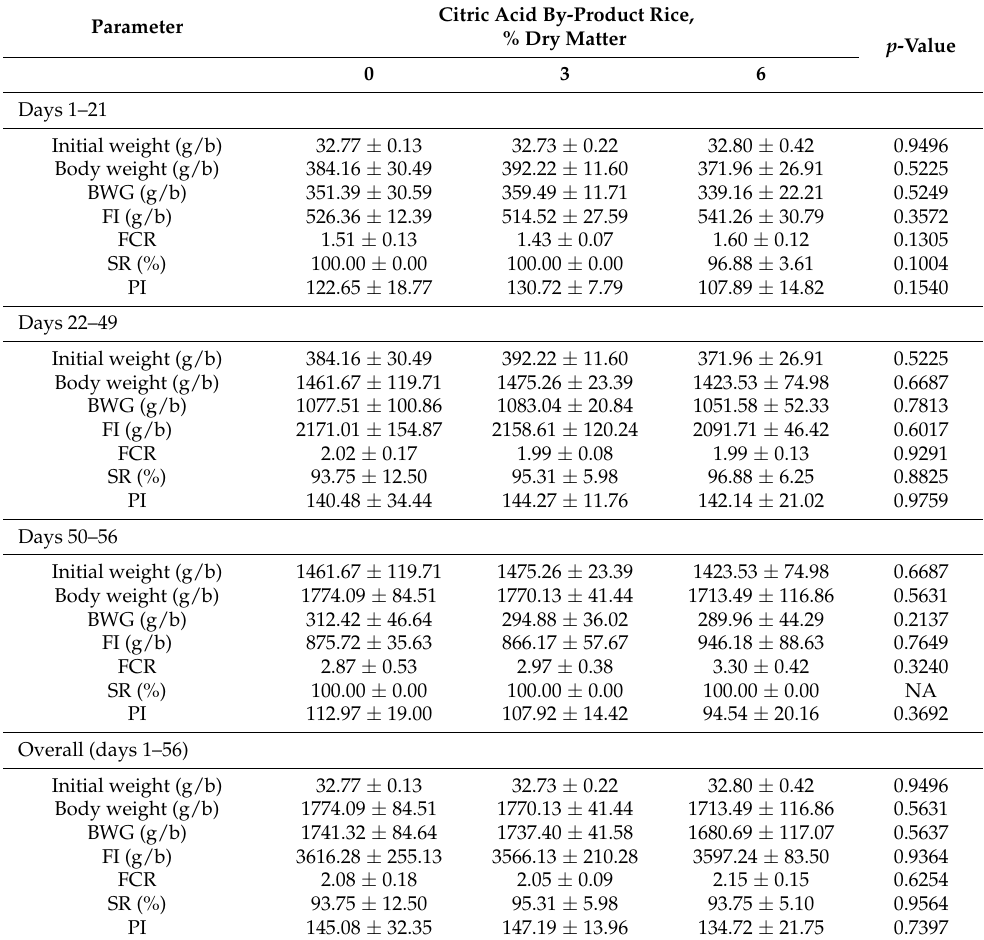
Table 2. Citric acid by-product from rice (CABR) utilization on growth performance of Thai native chicken (KKU 1) throughout 1–56